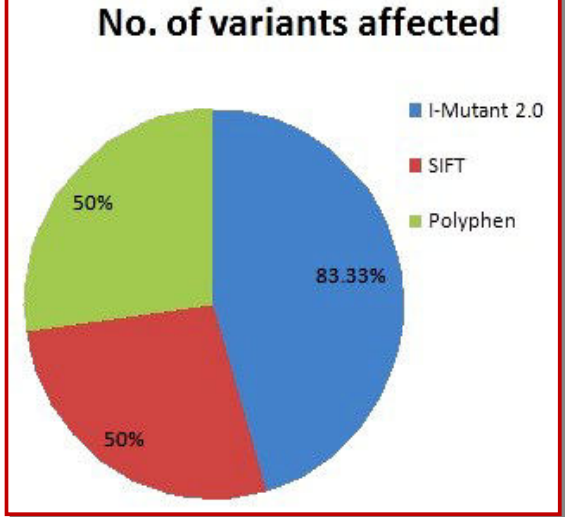
Figure 1: List of functionally significant